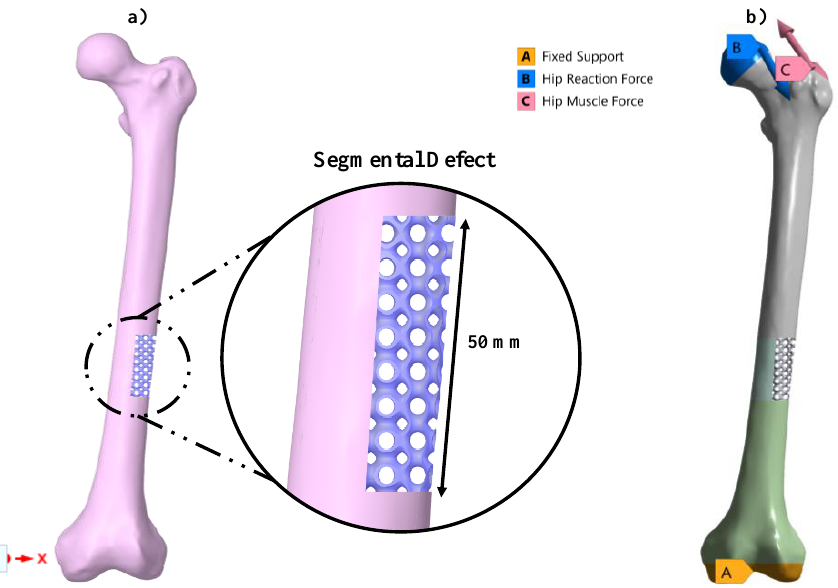
Figure 4. Typical views of construct ( a ) Femur critical size defect replaced with anatomically matched scaffold ( b ) Loading and boundary conditions on the construct.